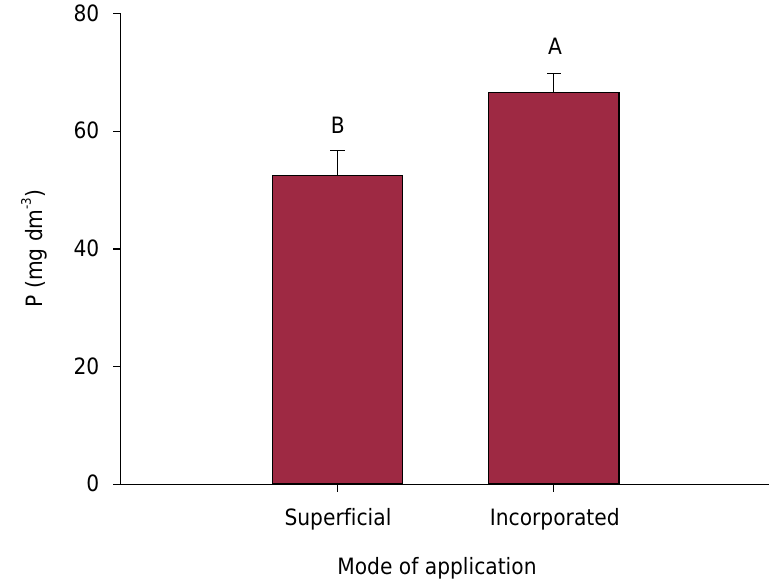
Figure 2. Available P (Mehlich-1) contents in the soil layer of 0.00-0.05 m in a Cambissolo Húmico Álico (Humic Cambisol) after three years of fertilization with applications on soil surface and incorporated into the soil. Means of contents from four reps and five tested fertilizations: mineral fertilizer (NPK), mineral fertilizer plus enzyme inhibitors (NPK+EI), pig slurry (PS), pig slurry plus enzyme inhibitors (PS+EI), and control without fertilization (TEST). Columns with the same letters do not differ among themselves by the Tukey test (p<0.05). Bars on the columns represent the standard error of the